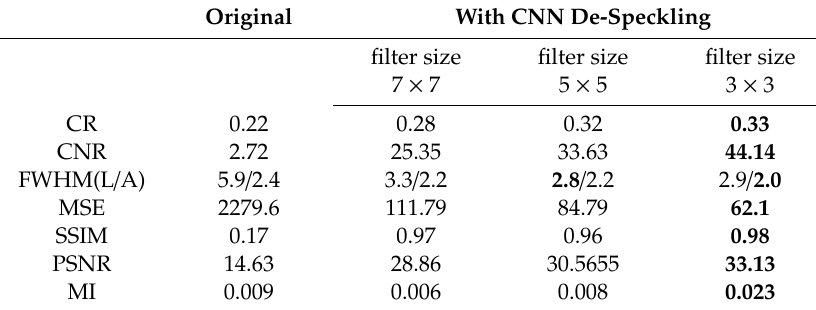
Table 5. Quantitative analysis of di ff erent filter